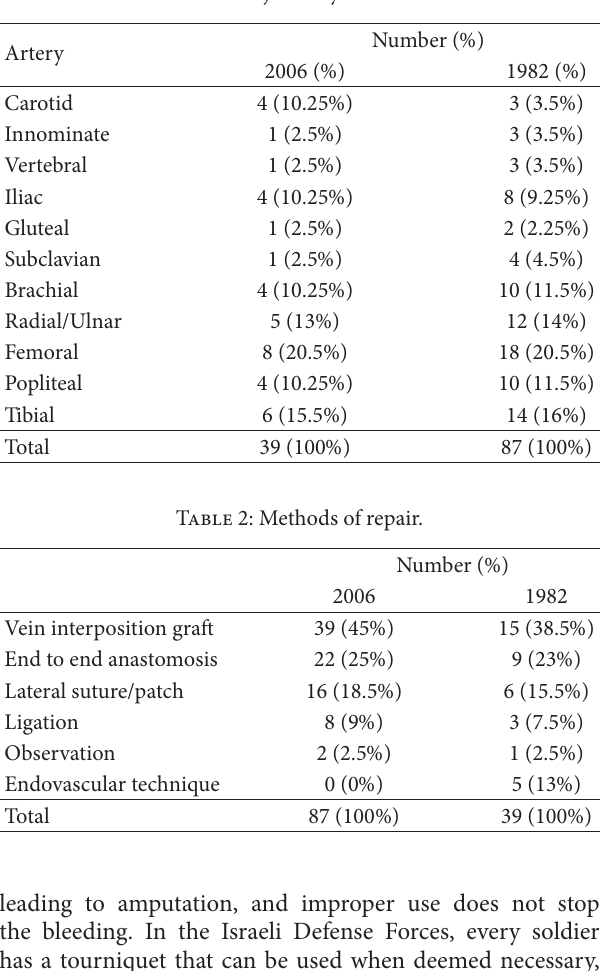
T 1: Arterial injuries by anatomic location.